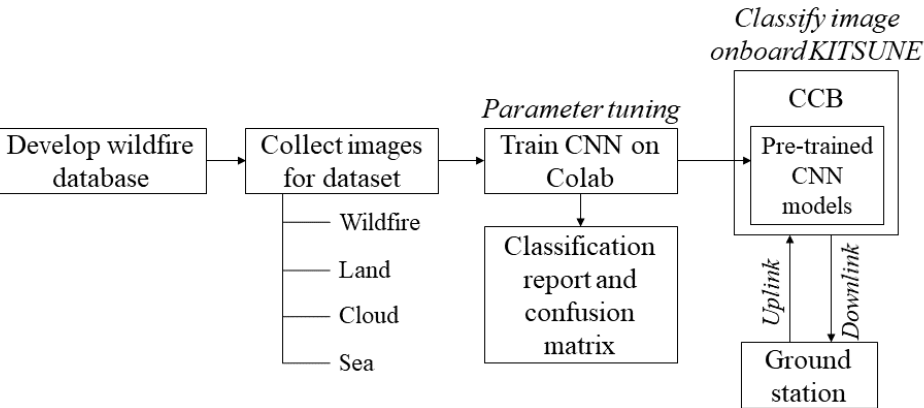
Figure 5. Flowchart of the study methods.